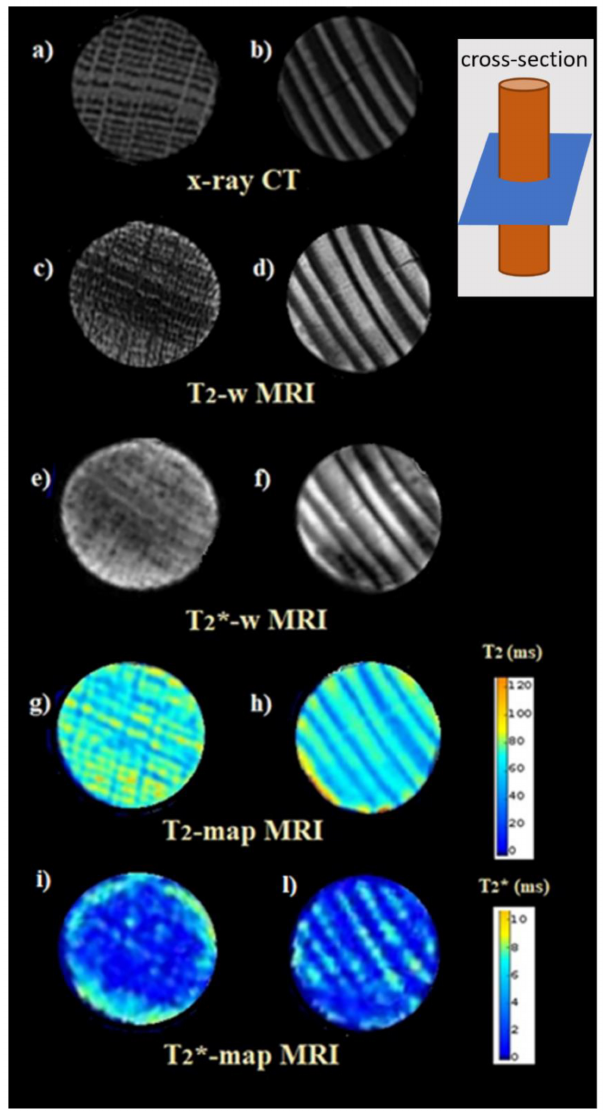
Figure 6. Image comparisons between: ( b , d , f , h , l ) one softwood sample; ( a , c , e , g , i ) one hardwood sample. Obtained by ( a , b ) CT scan; ( c , d ) T 2 -w MRI; ( e , f ) T 2 *-w MRI; ( g , h ) T 2 -map MRI; ( i , l ) T 2 *- map MRI. The scheme in the upper right corner shows how the virtual slice was cut from the cylinder sample to obtain the image. On the right, the two color bars indicate from bottom to top the increase in the T 2 and T 2 * values. See also Tables 4 and 5 in which T 2 and T 2 * values of waterlogged wood are reported. The mean cross-section diameter of wood samples is 2.95 ± 0.05 cm, and it is 20.0 ± 0.1 cm